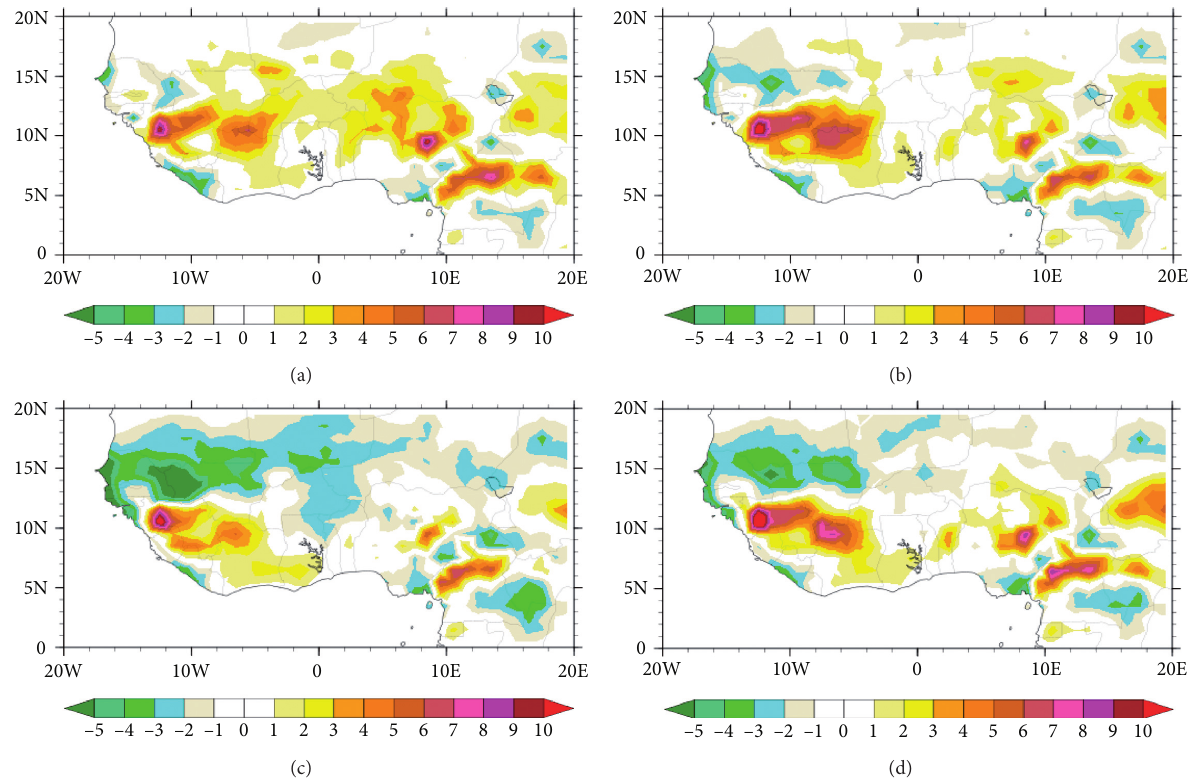
Figure 8: Spatial bias of precipitation for July 16 th –Sept 29 th , 2012. (a) Noah-MP groundwater option-TRMM. (b) Noah-MP-TRMM. (c) Noah-TRMM. (d)